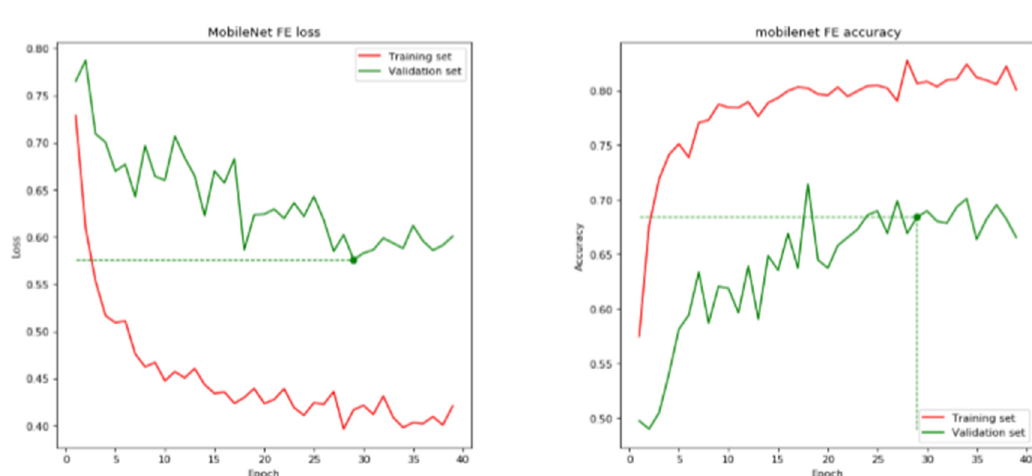
Figure 6. MobileNet Feature Extraction.